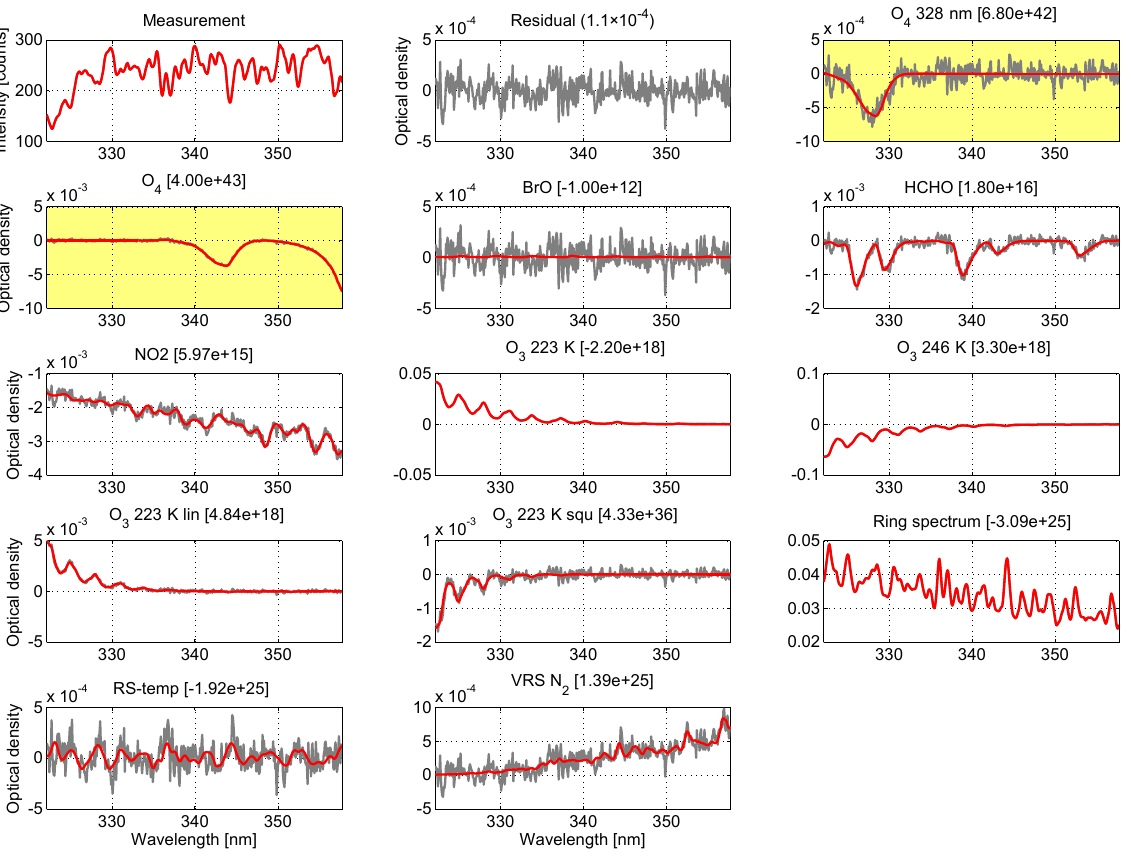
Figure 4. MAX-DOAS fit from PPAO, 6 July 2015, 11:18UTC, at 3 ◦ elevation and a 90 ◦ elevation reference spectrum. Spectra were co- added to obtain a total exposure time per spectrum of 4min. The 328nm O 4 absorption structure found here is 14 times as large as the DOAS fit error. Without considering this absorption, the HCHO dSCD in this case is larger ( the residual increases by 22%. “RS-temp” denotes the difference between Ring pseudo-absorption spectra calculated at 273 and 243K as + listed in Table